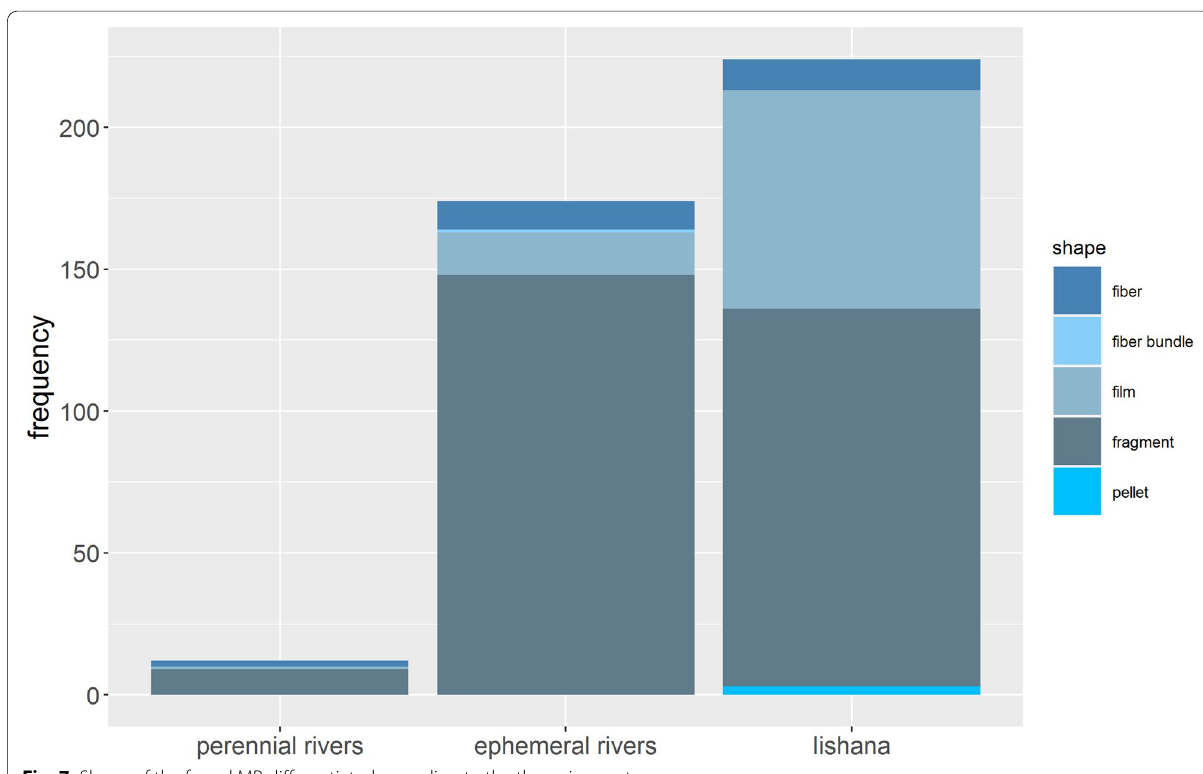
Fig. 7 Shape of the found MP, differentiated according to the three river